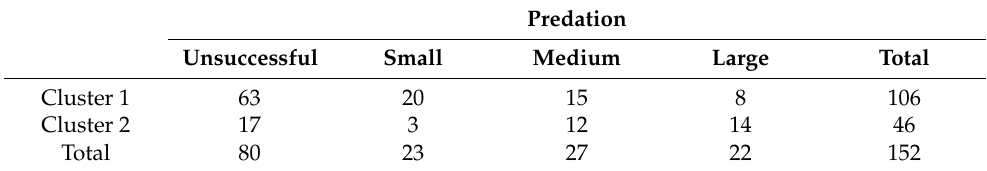
Table 2. The distribution of the number of successful predations on the prey of different sizes in the two clusters during the tests.